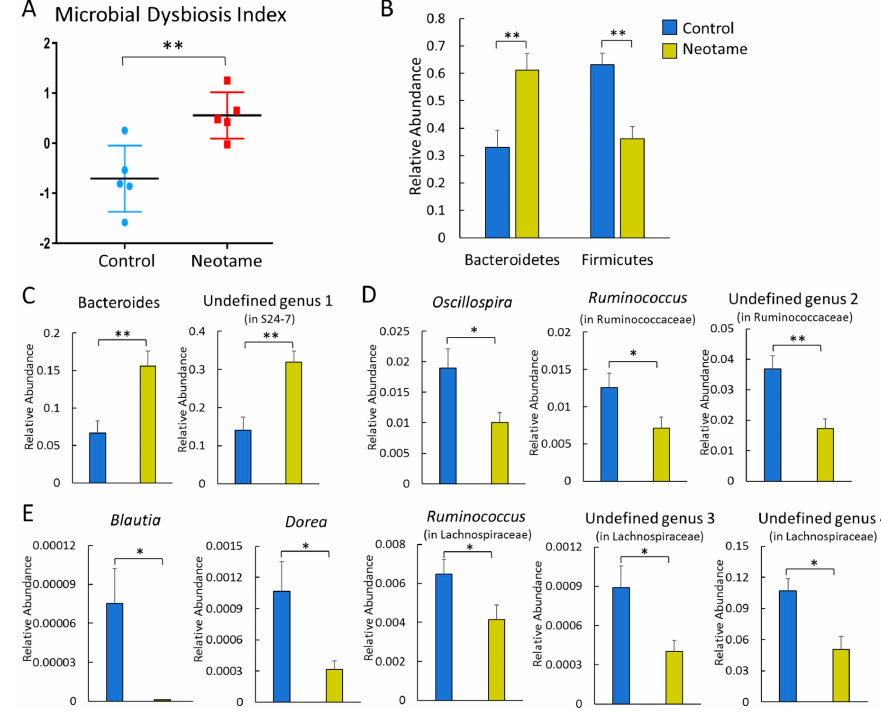
Figure 2. ( A ) Neotame-treated gut microbiome ( n = 5) has a significant higher MD-index than controls ( n = 5); ( B ) Phylum Bacteroidetes has been enriched in neotame-treated mice, while Firmicutes has been reduced; ( C ) Two main altered genera in phylum Bacteroidetes; ( D ) Significantly decreased three genera in family Ruminococcaceae; ( E ) Significantly decreased five genera in family Lachnospiraceae. (* p < 0.05; ** p < 0.01).